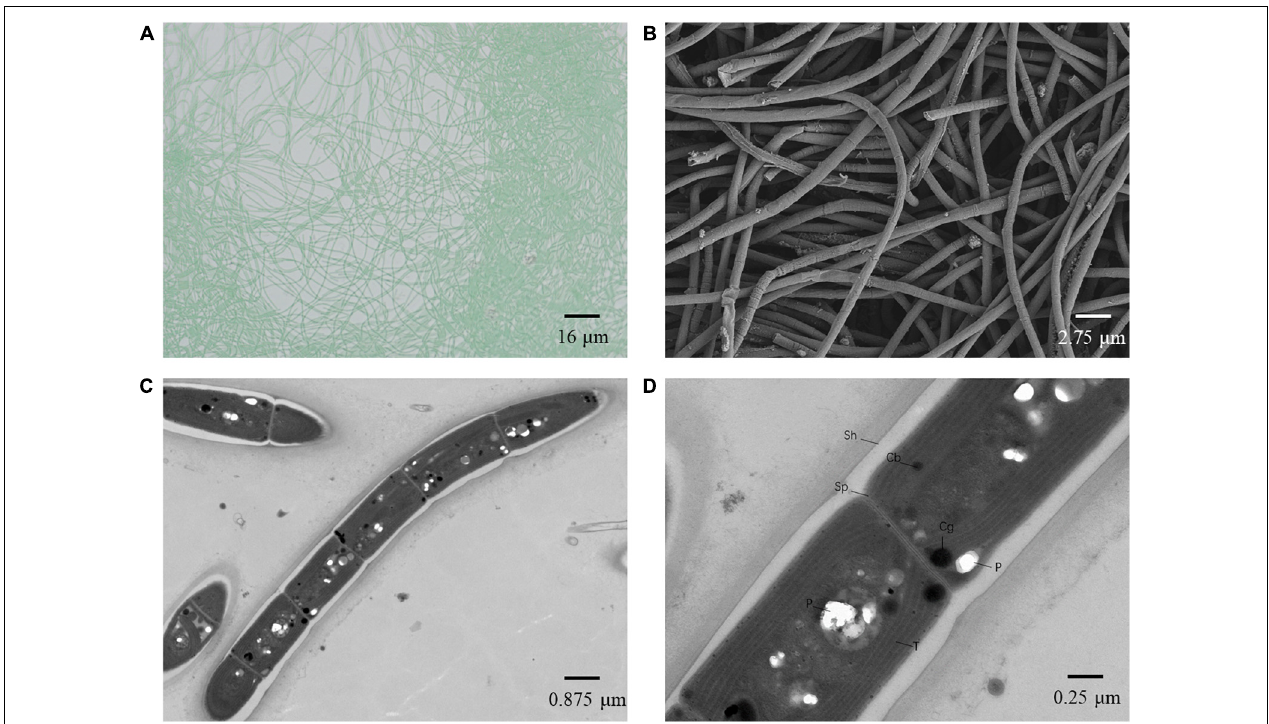
FIGURE 5 | Microscopic images of Leptodesmis sp. A121. (A) light microscopy image. (B) SEM image. (C,D) TEM images. Cb, carboxysome; Cg, cyanophycin granule; P, polyphosphate body; Sh, sheath; Sp, septum; T, thylakoid membrane. Magnifications were 400 × (A) , 5,000 × (B) , 8,000 × (C), and 12,000 × (D)